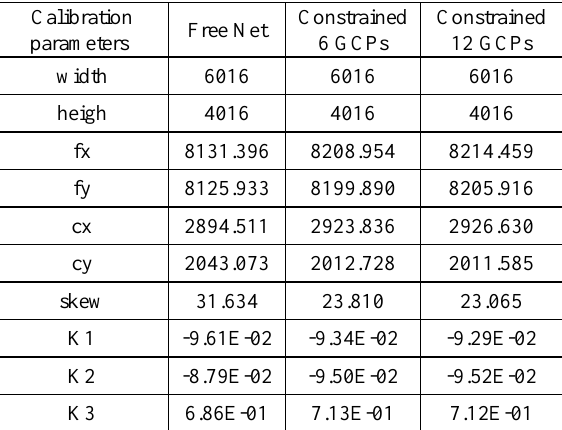
Table 3. Camera calibration parameters calculated by Photoscan